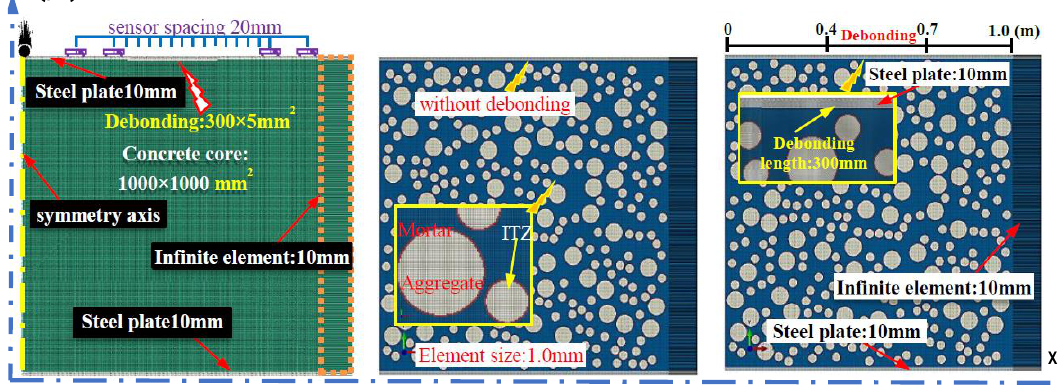
Figure 5. The element meshing and boundary setting (mesh size: 1.0 mm).